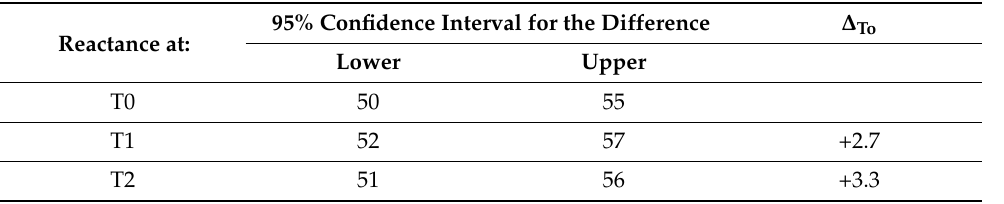
Table 3. Cyclotron—lower and upper values of reactance ( Ω ). The delta of the average reactance values ( ∆ To ) are Table 3. Cyclotron— lower and upper values of reactance (Ω). The delta of the average reactance values ( Δ To ) are included.